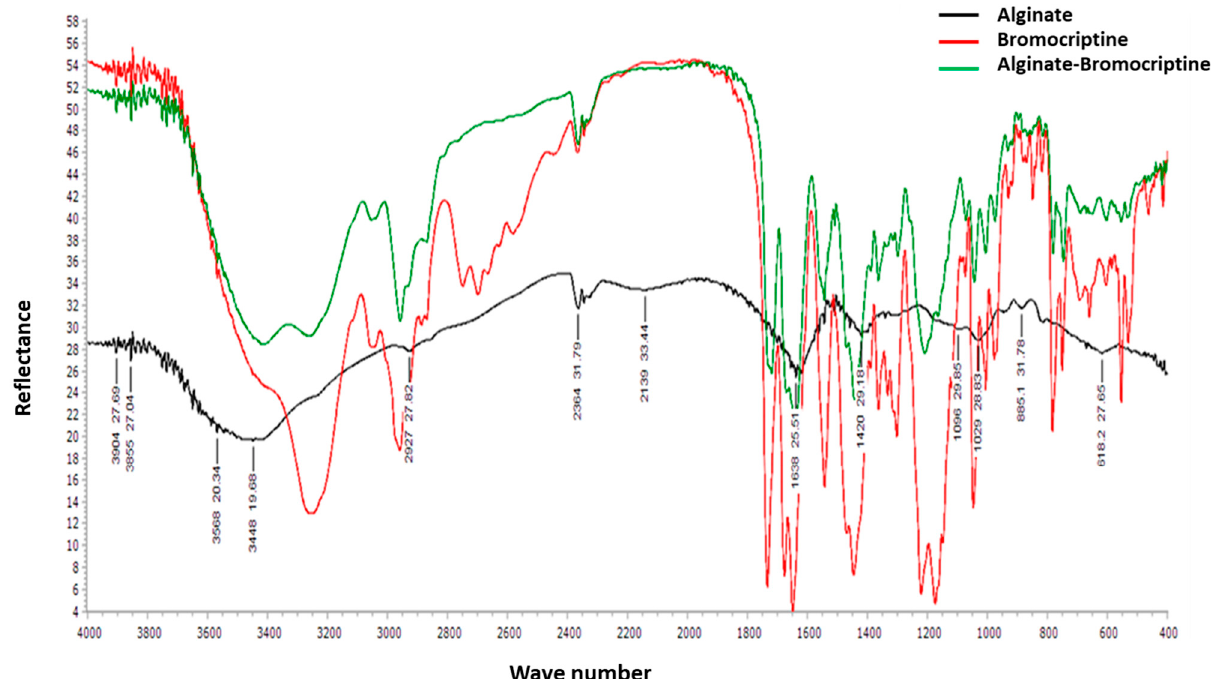
Figure 1. Fourier transform infrared (FTIR) spectra of alginate bromocriptine.